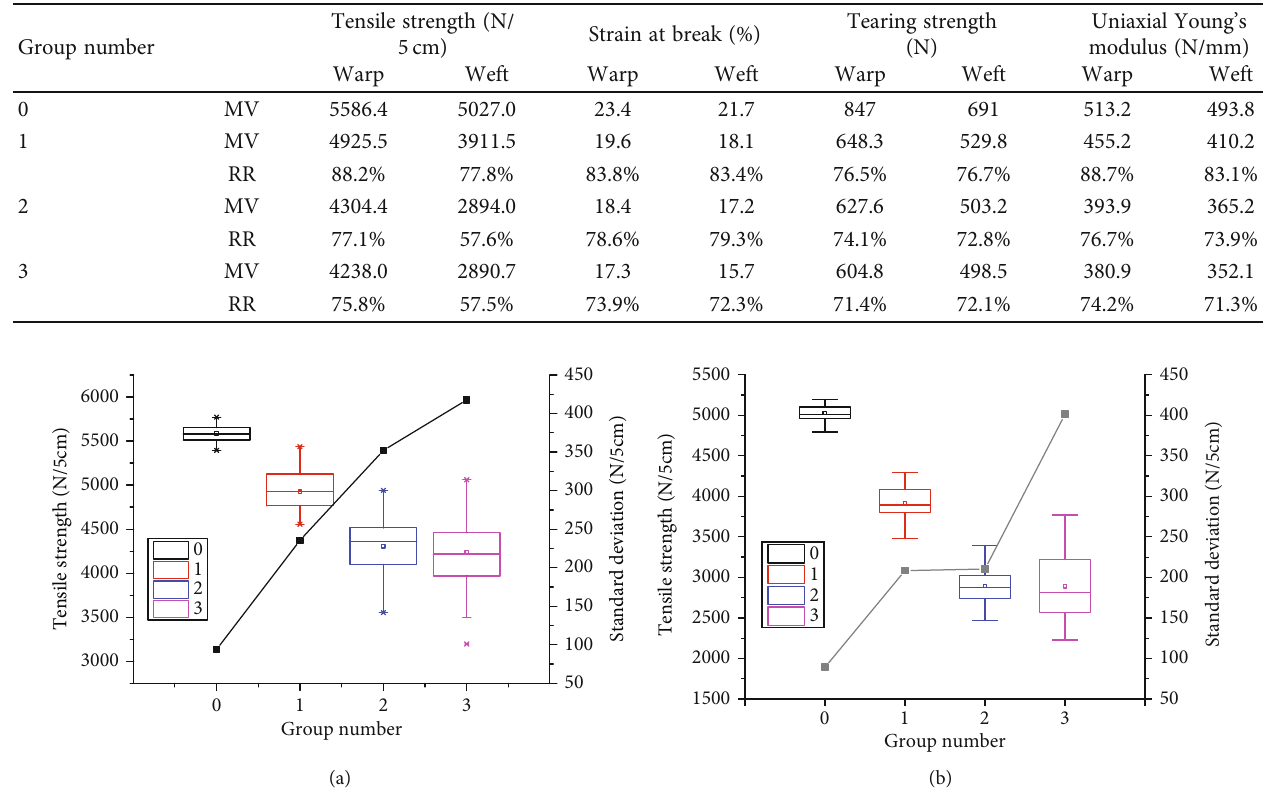
Table 5: Mechanical properties (mean value and retention rate) of experimental coated fabrics.